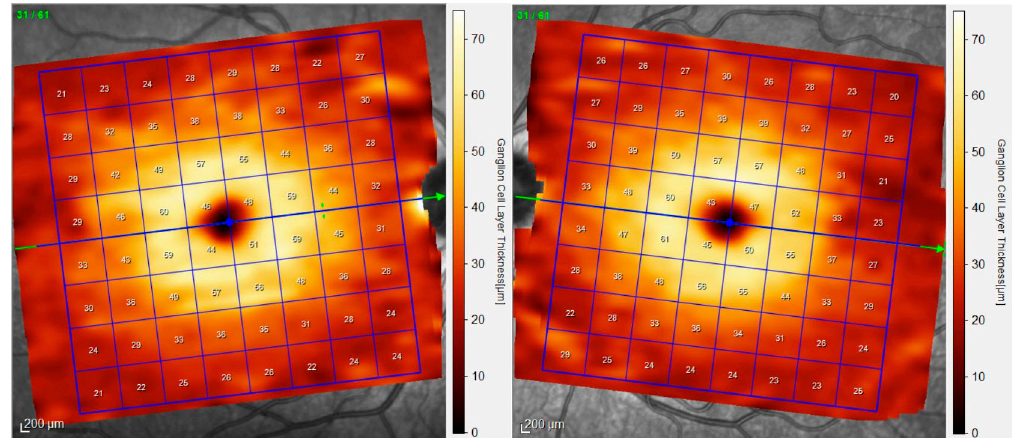
Figure 1. 8 × 8 Posterior Pole Algorithm (8 × 8 PPA). This algorithm is made up of 64 cells or superpixels 3 degrees wide. Automatic alignment of the horizontal meridian according to fovea-disc axis induces a slightly rotation of the grids of the right and left eye. The numbers inside the cells indicate mean thickness in microns. In this example, ganglion cell layer is represented.